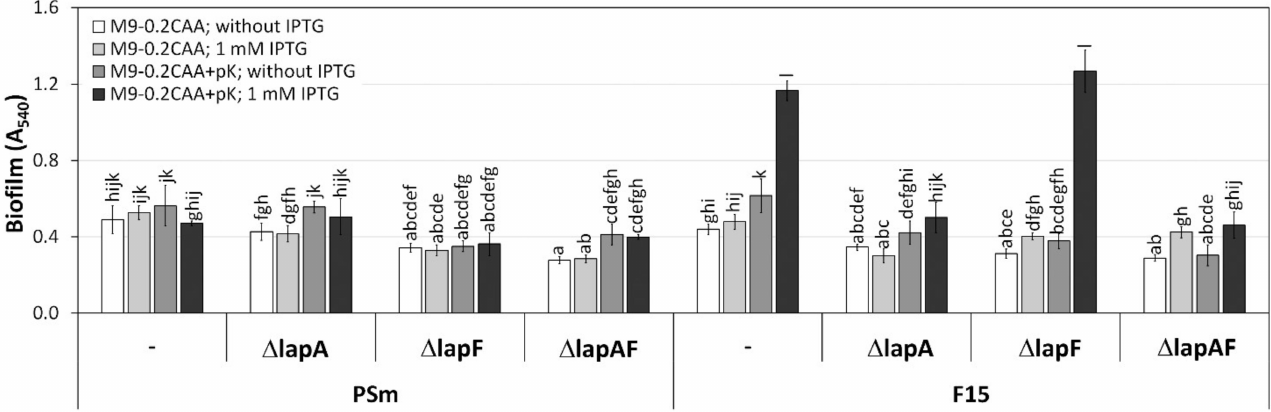
Figure 2. Biofilm of P. putida strains PSm, F15, and deletion-mutants ∆ lapA, ∆ lapF, and ∆ lapAF constructed from them in the M9-0.2CAA medium with poly-L-lysine (pK) or without it. “-“ indicates original strain without deletions. Cells were grown with or without 1 mM IPTG. Arithmetic means of at least three independent sets of measurements are shown. The 95% confidence intervals of the arithmetic mean and the homogeneous groups are shown above the columns by lower-case letters, tested by following Bonferroni’s test for unequal n. Identical letters in homogenous groups denote nonsignificant differences ( p ≥ 0.05) between averages of